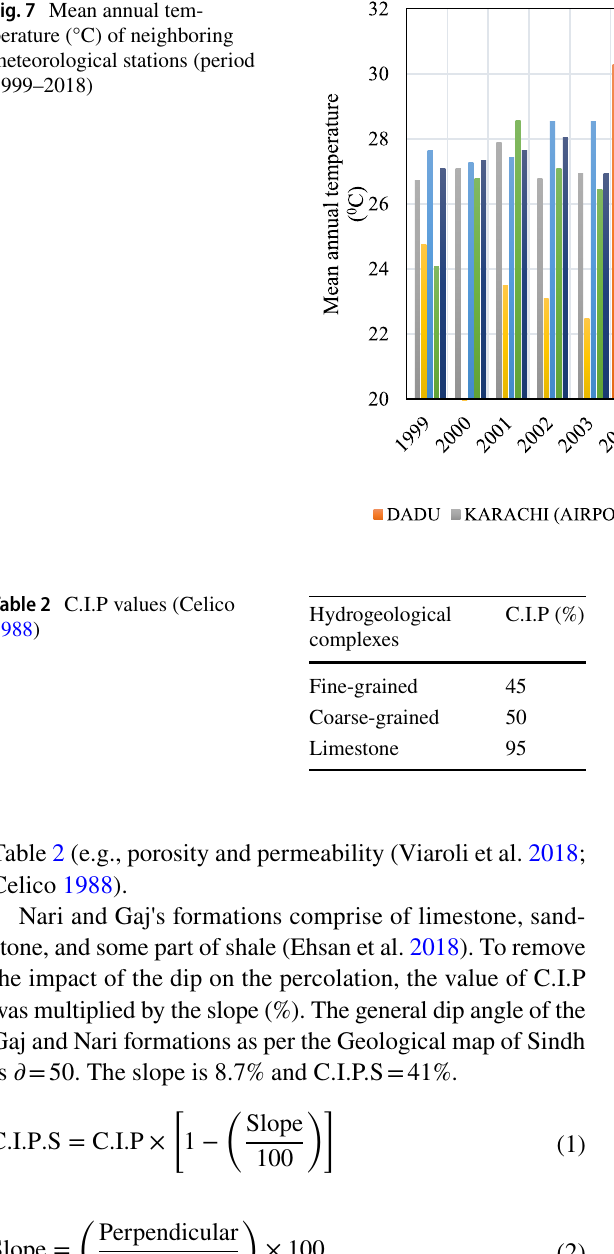
Fig. 7 Mean annual tem-